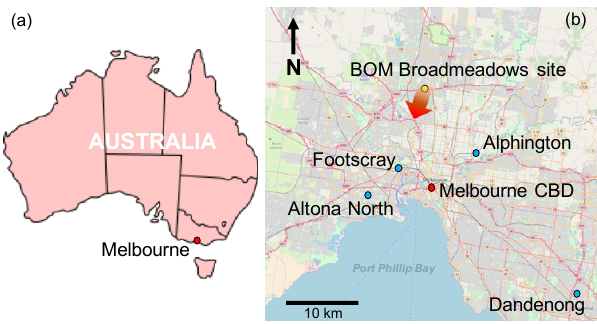
Figure 1. (a) Map of Australia showing the location of Melbourne. (b) Map of the Melbourne metropolitan area showing the location of the Broadmeadows measurement site (yellow marker) in the north- ern suburbs. The red arrow shows the south–south-west viewing di- rection of the MAX-DOAS instrument. The blue markers indicate the four Victorian EPA NO 2 measurement sites, which are referred to in the results